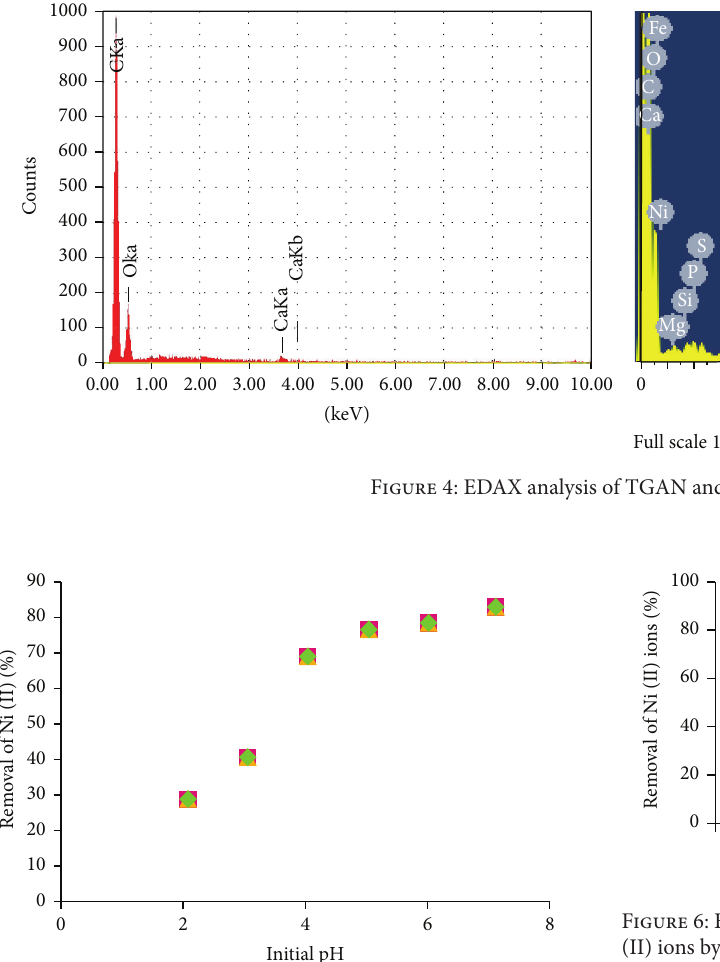
Figure 5: Effect of solution pH on the adsorption of Ni (II) ions on TGAN.